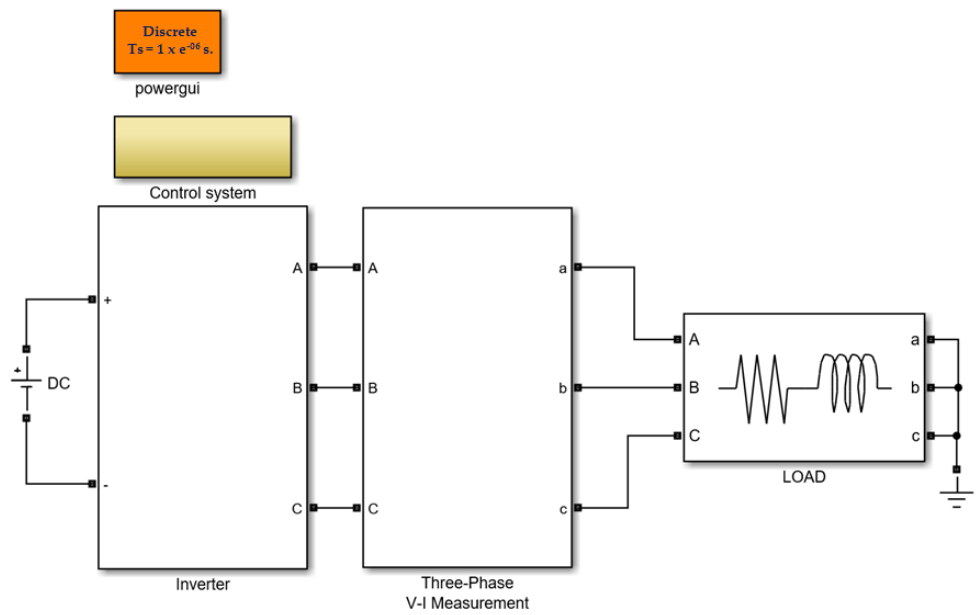
Figure 3. Simulink-model to test the proposed control method.